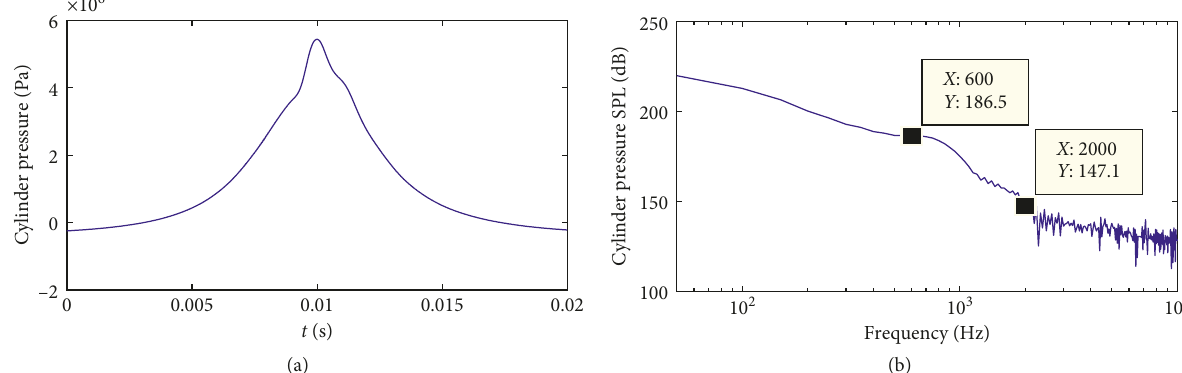
Figure 12: Cylinder pressure. (a) Time domain signal and (b) amplitude-frequency curve.